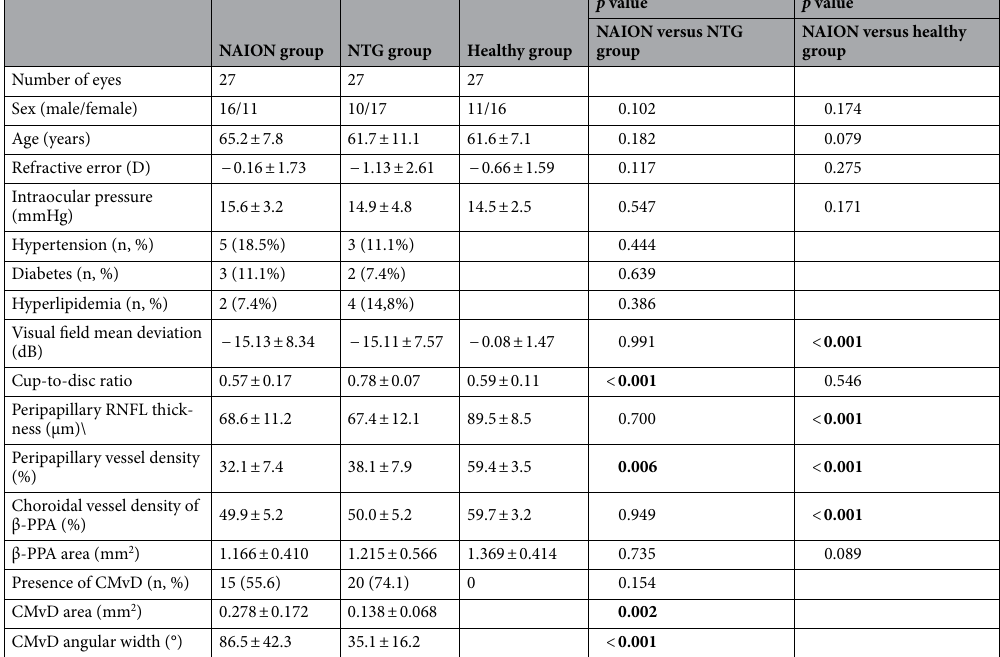
Table 1. Comparisons of the demographic and clinical characteristics among the NAION, NTG, and healthy control eyes. β-PPA β-zone peripapillary atrophy, CMvD Choroidal microvasculature dropout, D Diopter,